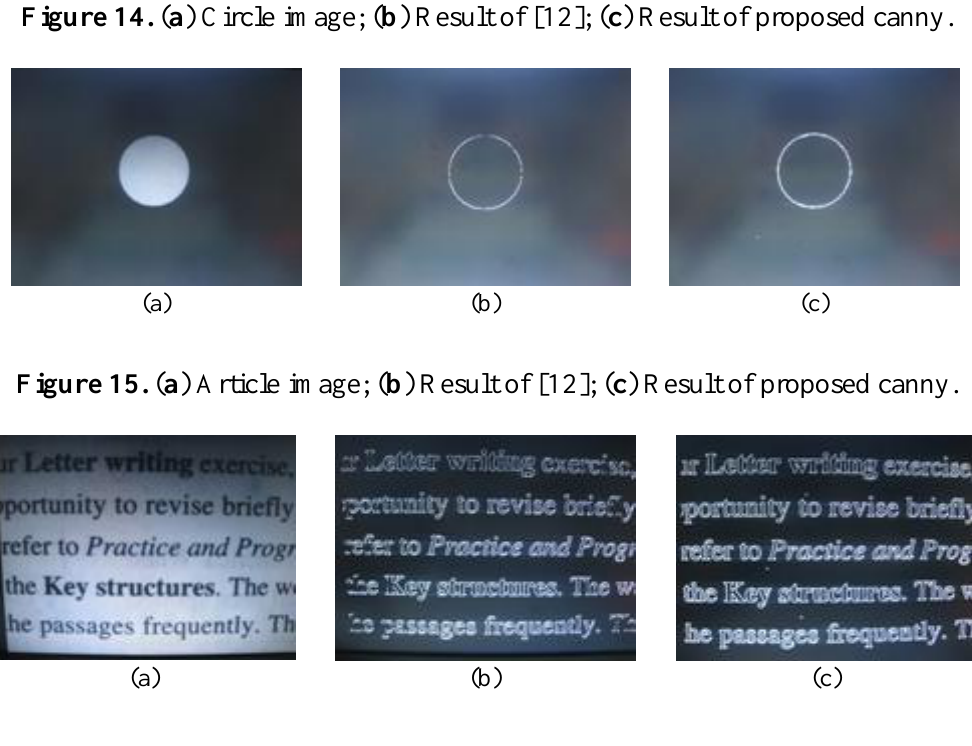
Figure 16. The experimental comparisons of LSM and PHT method: (a-1)–(a-4) are the original images; (b-1)–(b-4) are the results of LSM of Ji et al. [3]; (c-1)–(c-4) are the result of the proposed